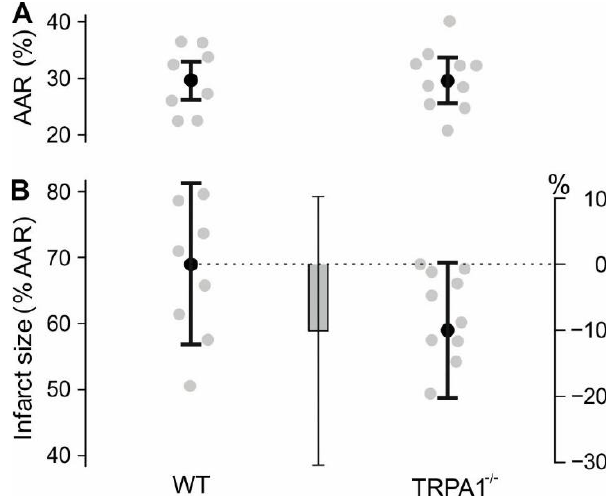
Figure 2. No evidence for a substantial effect of TRPA1 deletion on myocardial infarction. ( A ) Area at risk (% of left ventricle, AAR). Every grey dot represents one mouse, black dots with error bars are means ± 95% CI. ( B ) Infarct size in percent of left ventricle area at risk, determined after 24 h. Every grey dot represents one mouse, the estimated means ± 95% CI are shown as black dots. The estimated difference between the groups is shown as grey bar ± 95% CI.